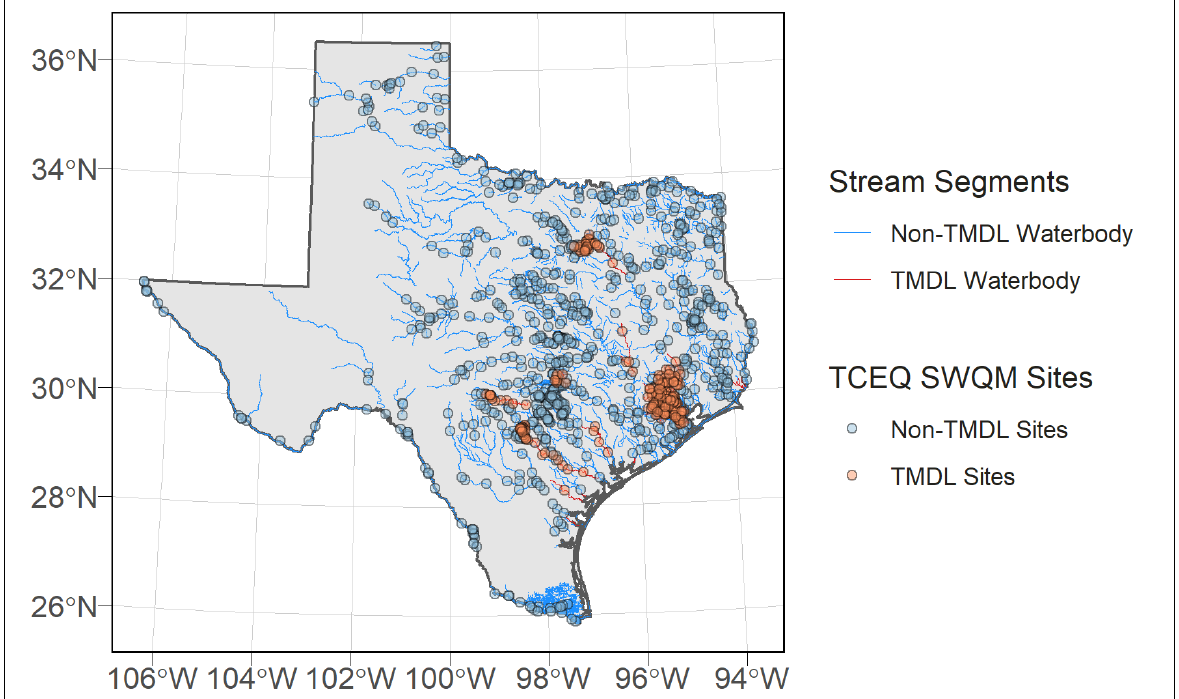
Figure 1. Map of TMDL and non-TMDL stream and SWQM site